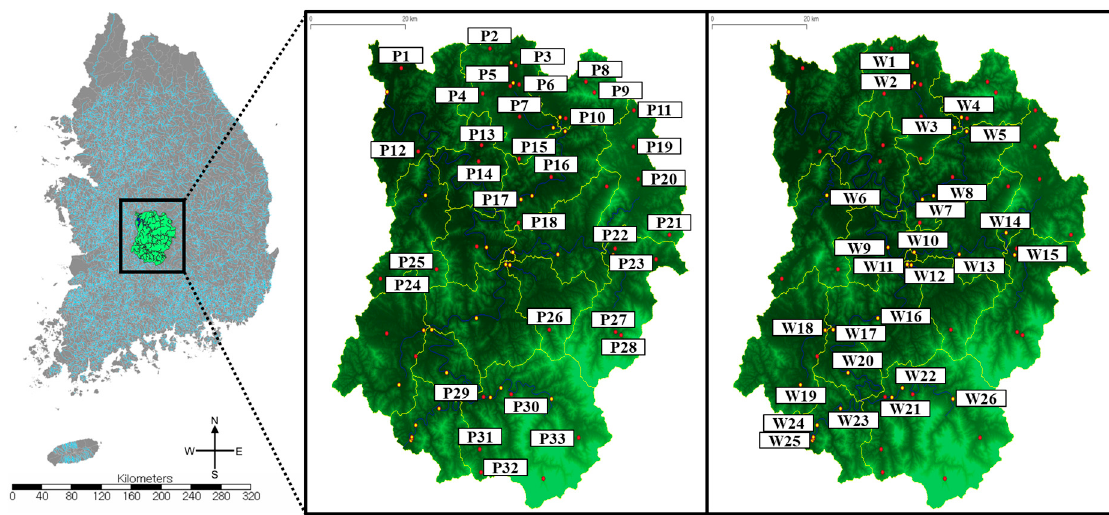
Figure 7. Study area (Daecheong Dam basin, South Korea): precipitation stations ( left ) and water level stations ( right ).